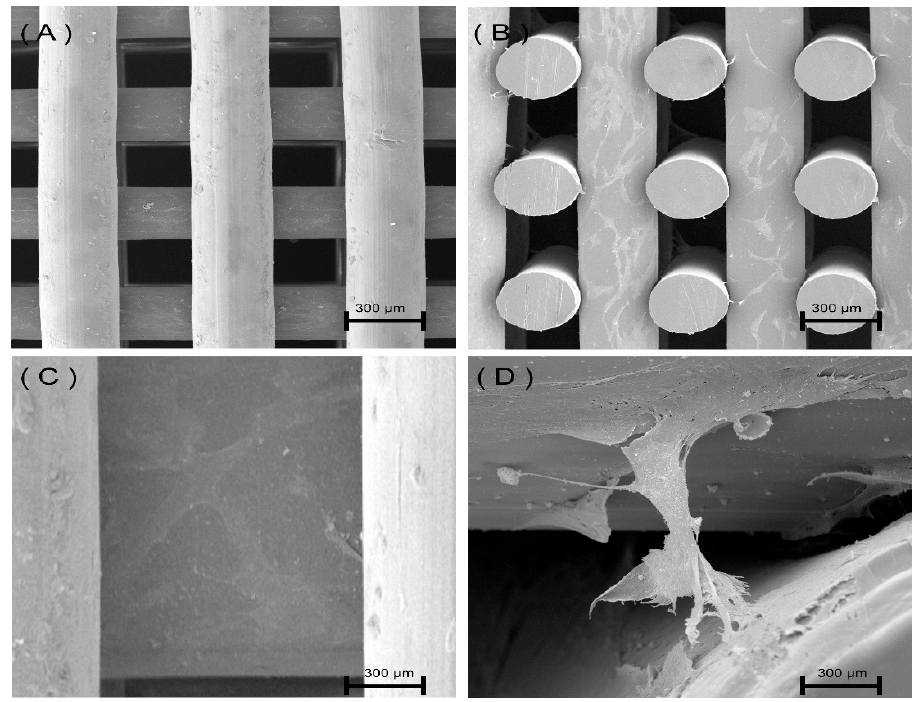
Figure 7. Cells on PETG-350 scaffolds after 14 days of cell seeding. ( A ) Top view image of the PETG scaffold, ( B ) cross-section image of PETG scaffold, ( C ) magnified image showing cells covering the PETG filament, ( D ) cells bridging adjacent layers.